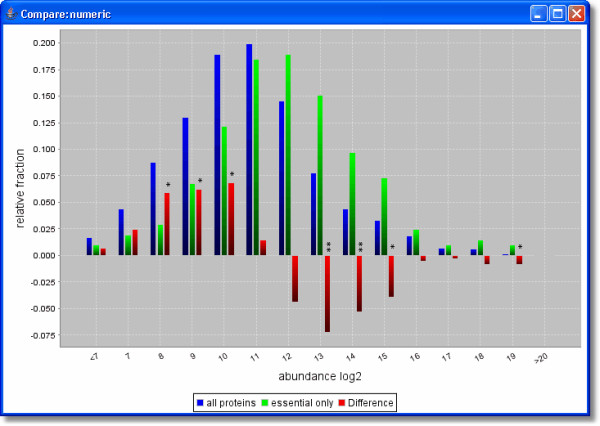
Comparison of two numeric distributions by PROMPT. Here normalized abundance distributions of all observed proteins (blue) and essential proteins only (green), as well as the relative difference (red) are shown. These distributions are significantly different (Kolmogorov-Smirnov p-value 6.2 E-12, Mann-Whitney p-value 1.7 E-13). Additionally the stars on top of the red bars show the specific intervals in which the difference is significant. The p-values are indicated by the number of stars: p-value *< 0.05, ** < 0.01 and *** < 0.001.